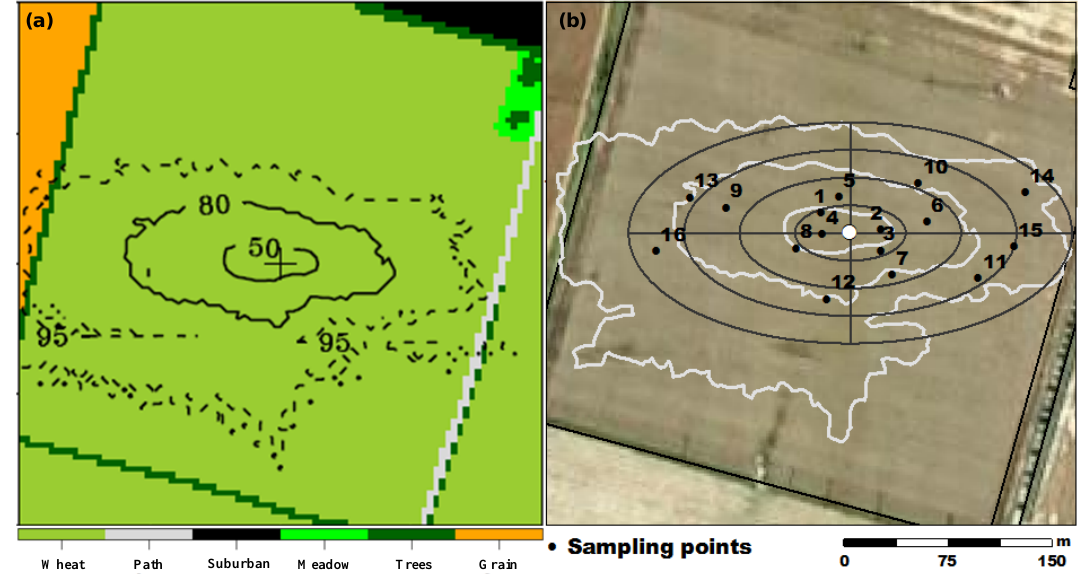
Figure 3. (a) Footprint of the eddy covariance station EC 1 in 2013. Black isolines indicate the fraction of the source area of 50, 80 and 95% of measured EC fluxes. (b) Positions of sampling points within the footprint of EC3 used to measure soil water storage.